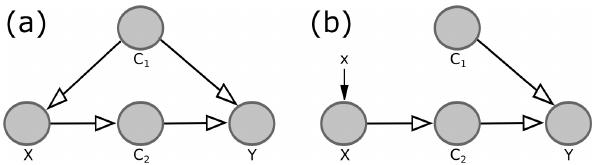
Figure 1. Example for a causal graph (a) and corresponding causal graph for setting variable X to some arbitrary value x (b) . The grey circles are referred to as nodes of the graph, while the arrows are referred to as directed